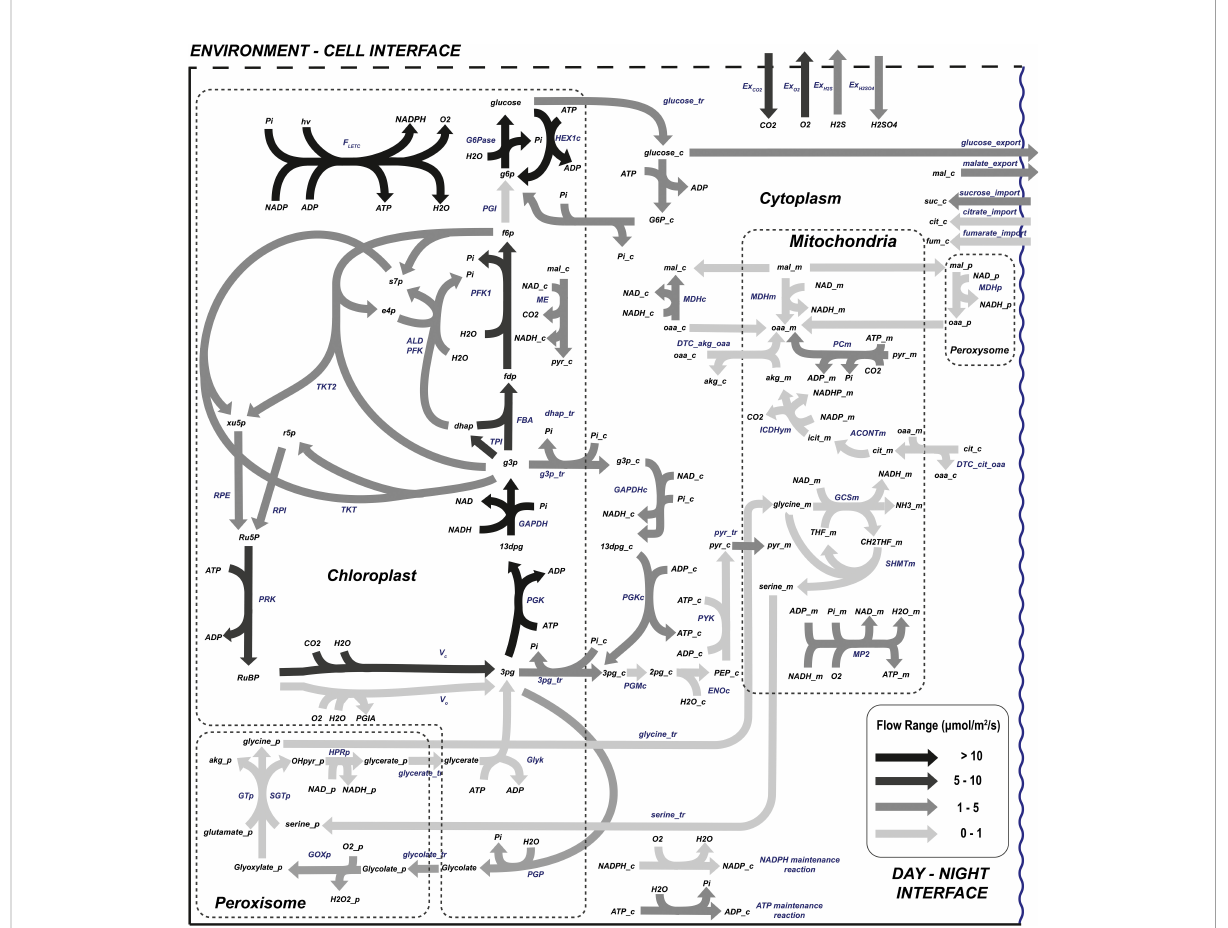
FIGURE 5 Flow distribution of the central carbon metabolism during L. sativa grown during the light photoperiod. List of abbreviated enzymes or enzyme reactions. In chloroplast: F LETC , fl ow of light electron transport chain; G6Pase, glucose-6-phosphatase; PGI, glucose-6-phosphate isomerase; MDH, malate dehydrogenase; FBPase, fructose-1,6-biphosphatase; PFK, phosphofruktokinase-1; ALD, aldolase; TKT, transketolase; TKT2, transketolase 2; FBA, fructose-1,6-biphosphate aldolase; TPI, triose-phosphate isomerase; RPI, ribose-5-phosphate isomerase; RPE, ribulose-phosphate 3-epimerase; GAPDHy, NADP-glyceraldehyde-3-phosphate dehydrogenase; PGK, phosphoglycerate kinase; PRK, phosphoribulokinase; V c , RuBisCo carboxylation; V o , RuBisCo oxgygenation; Glyk, D-glycerate 3-kinase; PGP, phosphoglycolate phosphatase. In peroxisome: GOXp, glycolate oxidase; SGTp, serine- glyoxylate transaminase; GTp, glycine transaminase; HPRp, hydroxypyruvate reductase; MDHp, malate dehydrogenase. In cytoplasm: PGMc, phosphoglycerate mutase; ENOc, enolase; PYKc, pyruvate kinase; PGKc, phosphoglycerate kinase; GAPDHc, NAD-glycerate-3-phosphate dehydrogenase; MDHc, NADH malate dehydrogenase; ICDHyc, NADP-based isocitrate dehydrogenase; ALDc, aldolase; PFK, phosphofructokinase; TALc, transaldolase. In mitochondria: ACONTm, aconitase; MDHm, malate dehydrogenase; GCSm, glycine cleavage system; SHMTm, serine hydroxymethyltransferase; CSm, citrate synthase; PCm, pyruvate carboxylase; MP2, mitochondrial phosphorylation 2. Carbohydrate reactions represent a set of lumped reactions related to carbohydrate